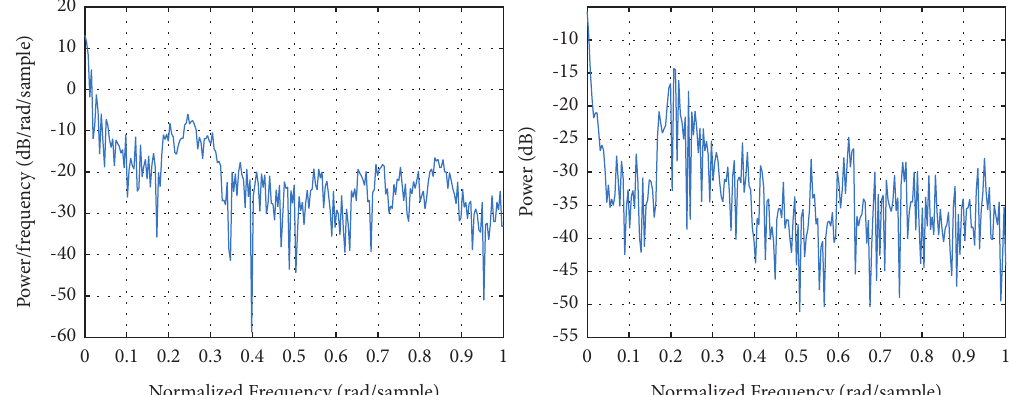
Figure 7: Evaluated